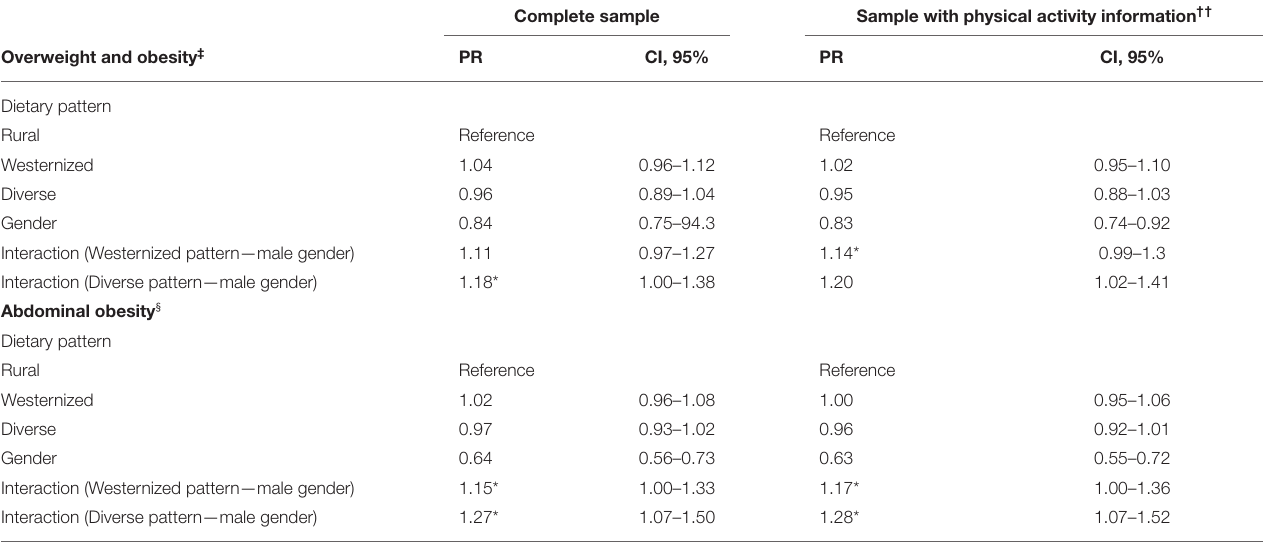
TABLE 5 | Association between dietary patterns with overweight and obesity and abdominal obesity in Mexican adults, in the complete sample and sample with physical activity ENSANUT-2016 †